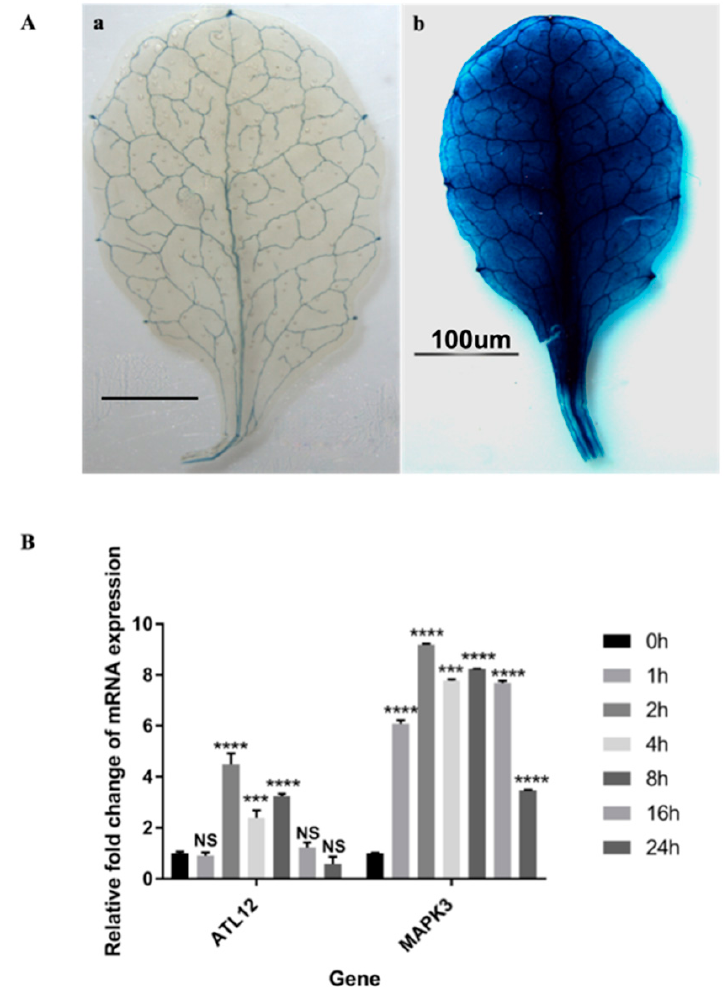
Figure 4. Expression pattern of ATL12 after chitin treatment. ( A ): Histochemical staining assay of pATL12-GUS. 4 weeks old transgenic plant leaves express pATL12-GUS in leaves were treated with water ( a ) or with ( b ) 1 mg/mL CSC treatment for 2 h, and then subject to GUS staining. ( B ). qRT-PCR analysis of ATL12 mRNA and MAPK3 expression in response to chitin at different time points. Asterisks indicate statistically significant differences between the samples treated and untreated, according to the One-way ANOVA analysis and multiple comparison post-Tukey’s test. The experiments were repeated three times. **** indicates p < 0.0001, *** indicates p < 0.001, and NS indicates not significant. The black scale bar indicates 100 um.